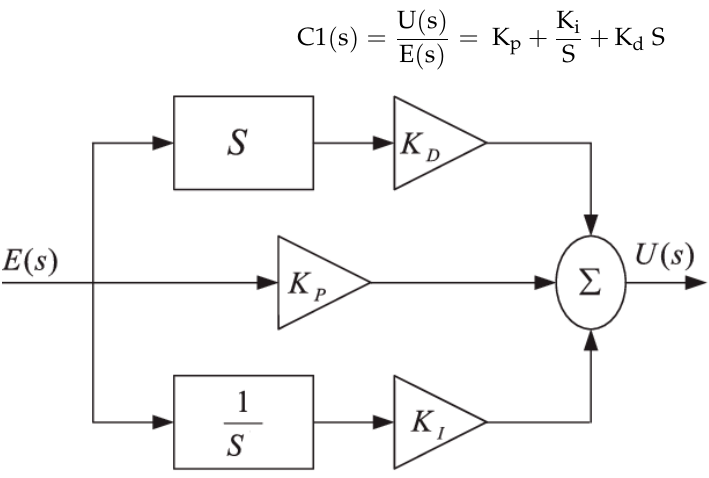
Figure 10. The PID controller structure.